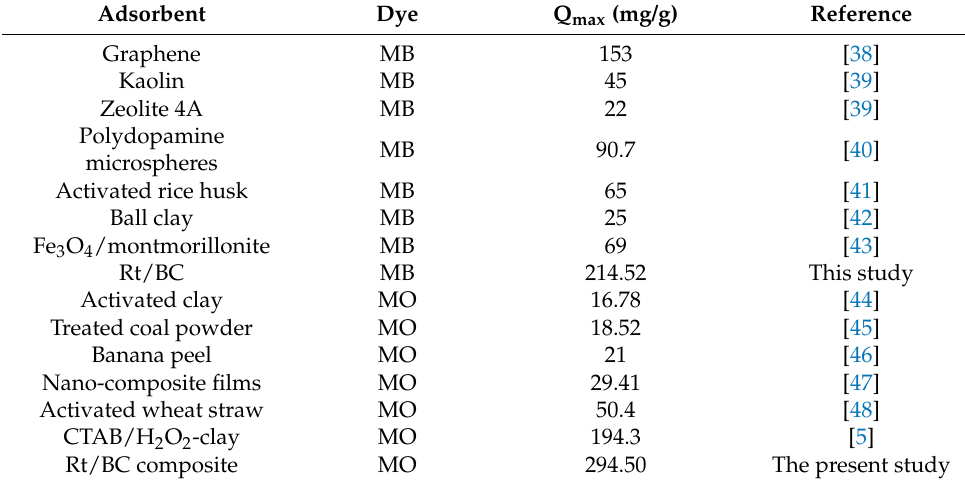
Table 2. MB and MO adsorption capacities of different